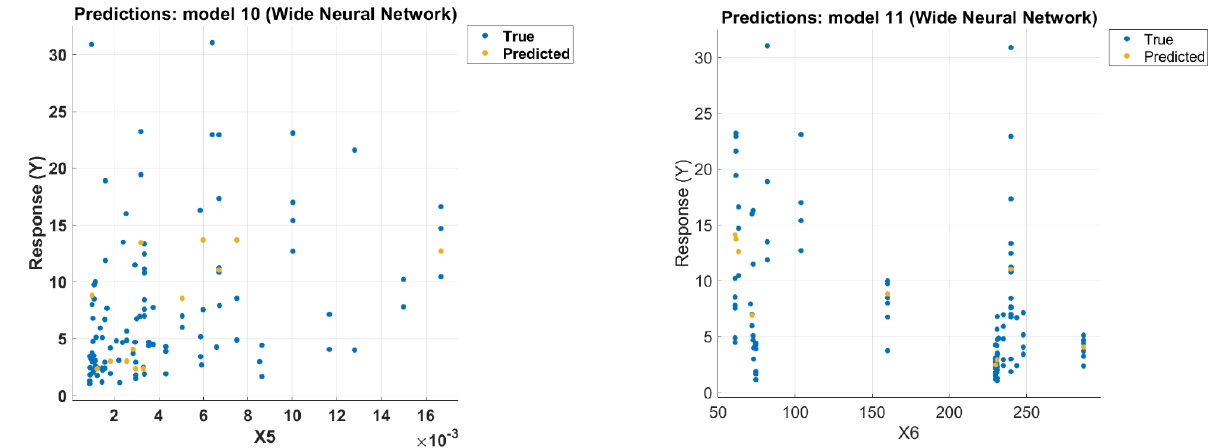
Figure 4. Effect of input parameter on the output prediction.